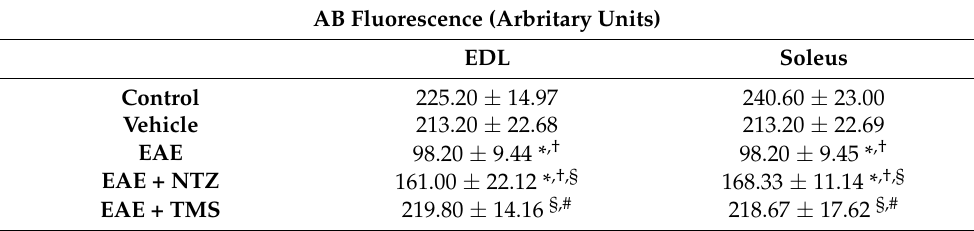
Table 3. Values of AlamarBlue (AB) fluorescence.